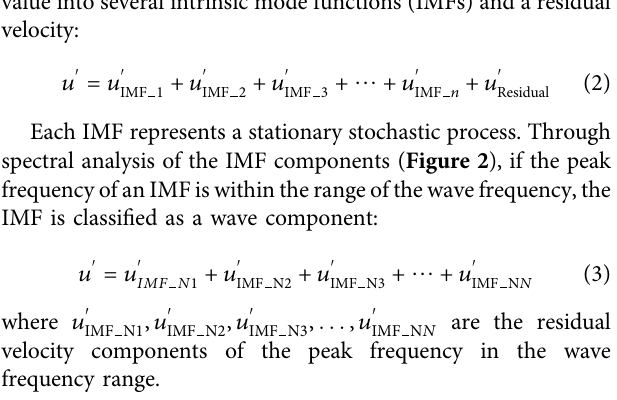
Frontiers in Earth Science |